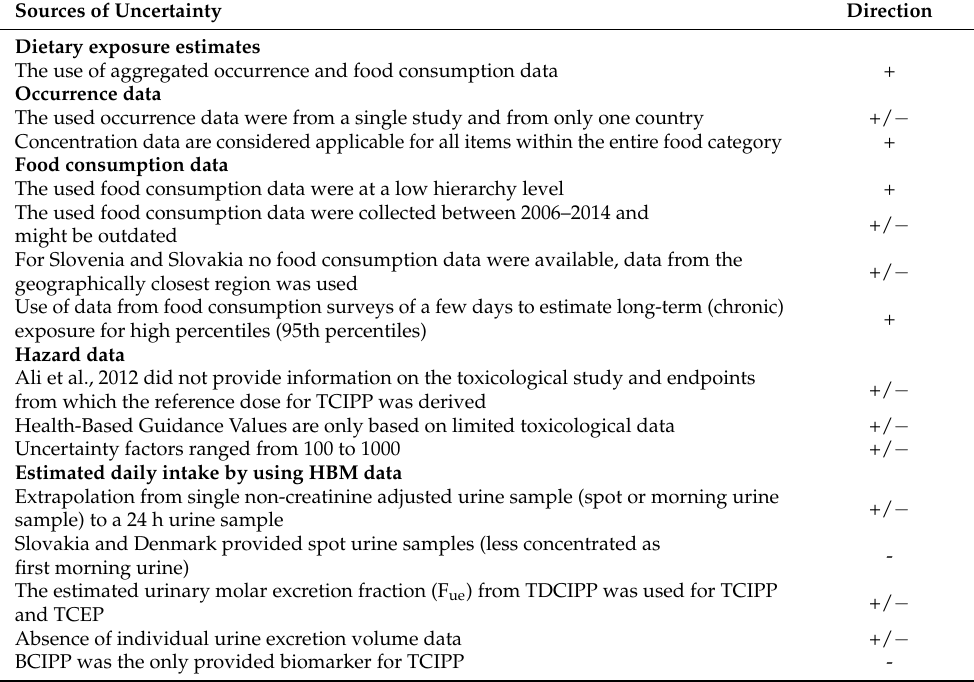
Table 5. Qualitative evaluation of influence of uncertainties on the dietary exposure estimate and the estimated daily